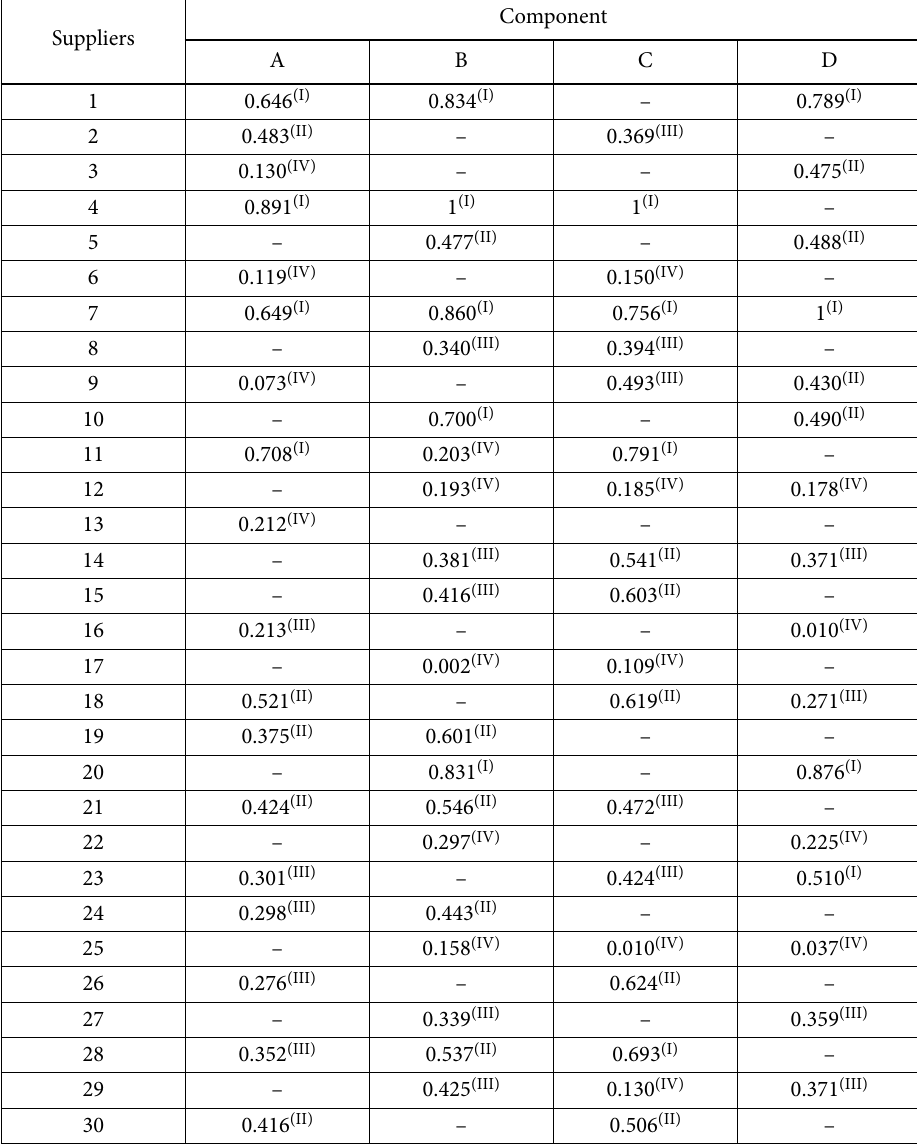
Table 13. Overall performance for components A to D of all potential suppliers